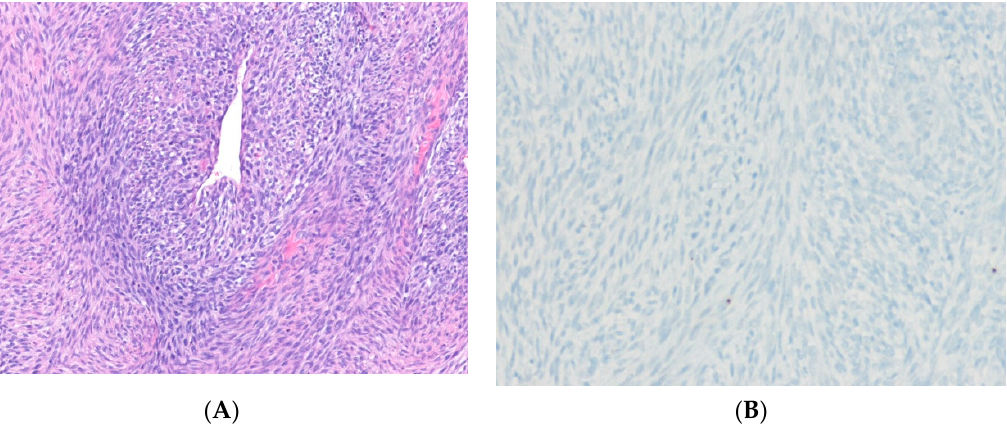
Figure 6. Malignant peripheral nerve sheath tumor. ( A ) The tumor shows spindle cells in a fascicular pa tt ern. Perivascular accentuation of cellularity is present (H&E stain, ×100). ( B ) The tumor cells show loss of H3K27me3 expression, indicating the presence of underlying inactivating mutations of the polycomb repressive complex 2 components ( SUZ12 or EED ) (immunohistochemical stain for H3K27me3, ×200). H3K27me3, ×